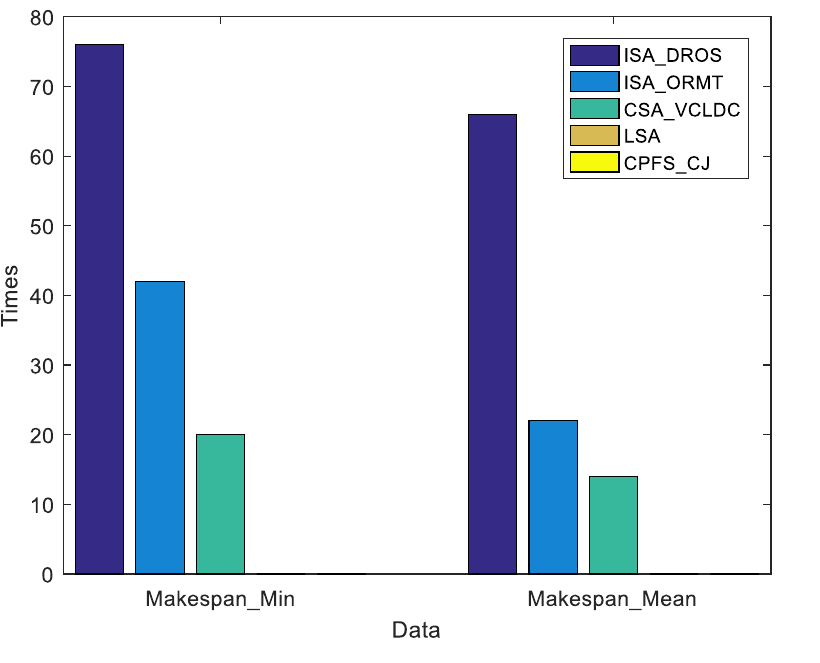
Figure 14. Figures 12 and 13 summarize the results.